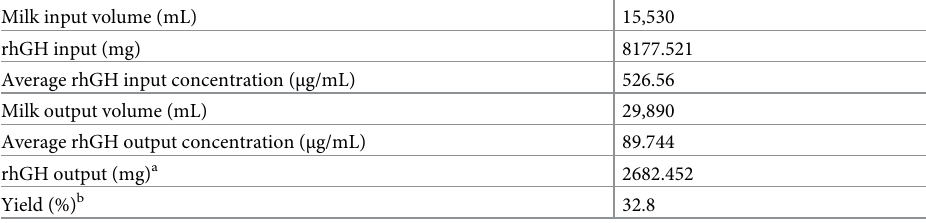
Table 5. Yield of transgenic sow milk after pretreatment.